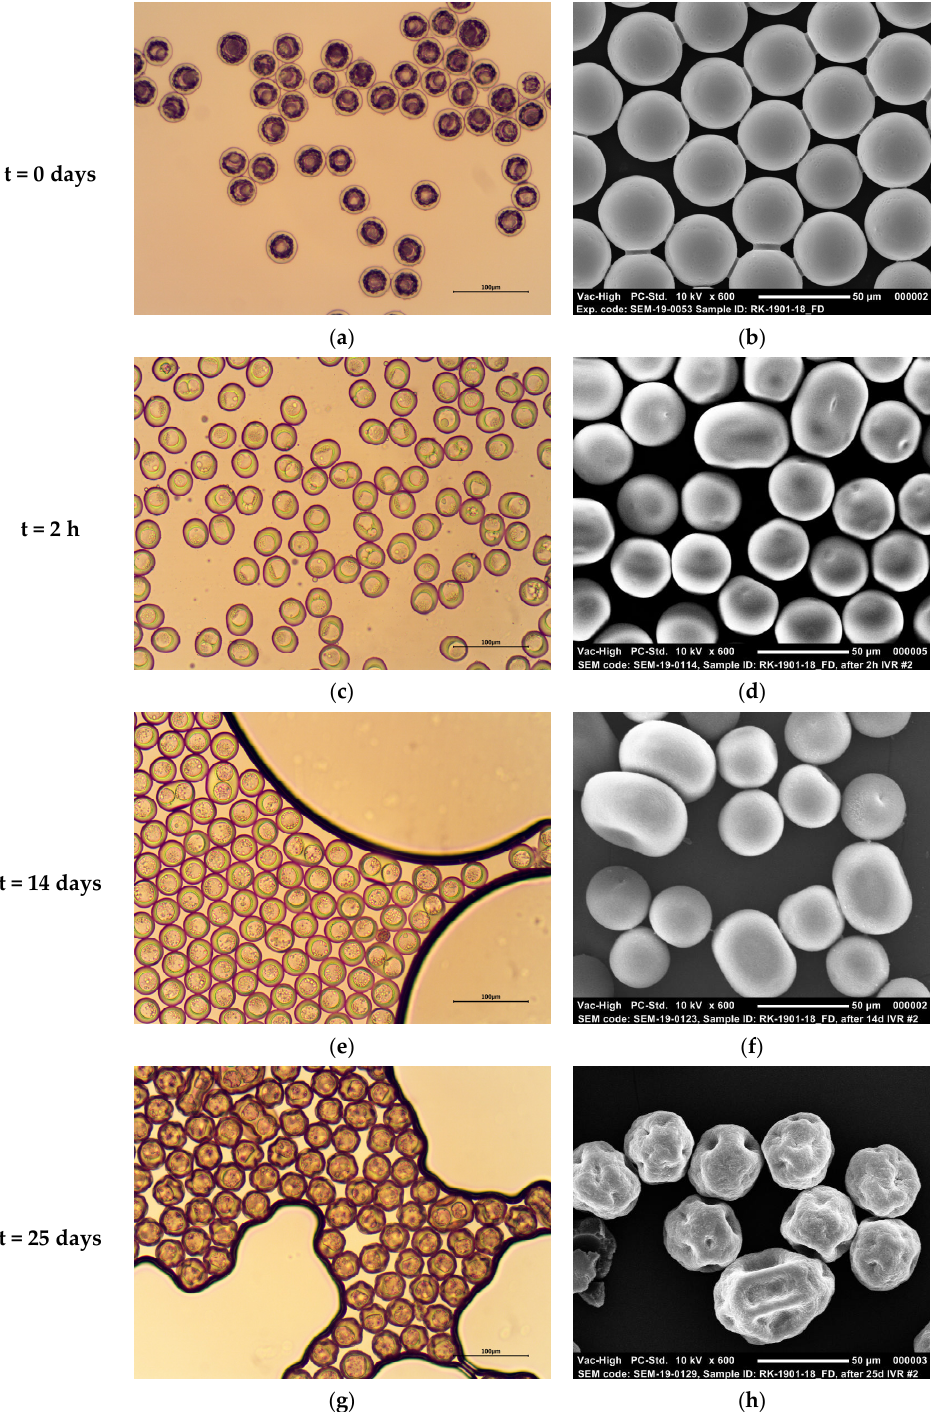
Figure 5. Representative microscopy images depicting the morphology of PDLG5002-based core–shell microspheres (formulation C) at different stages before and during the in vitro release of BSA. ( a , b ) Images of the initial microspheres after washing and freeze drying and before release; ( c , d ) 2 h after release; ( e , f ) 14 days after release; ( g , h ) 25 days after release. Left panel: optical microscopy images, right panel: SEM